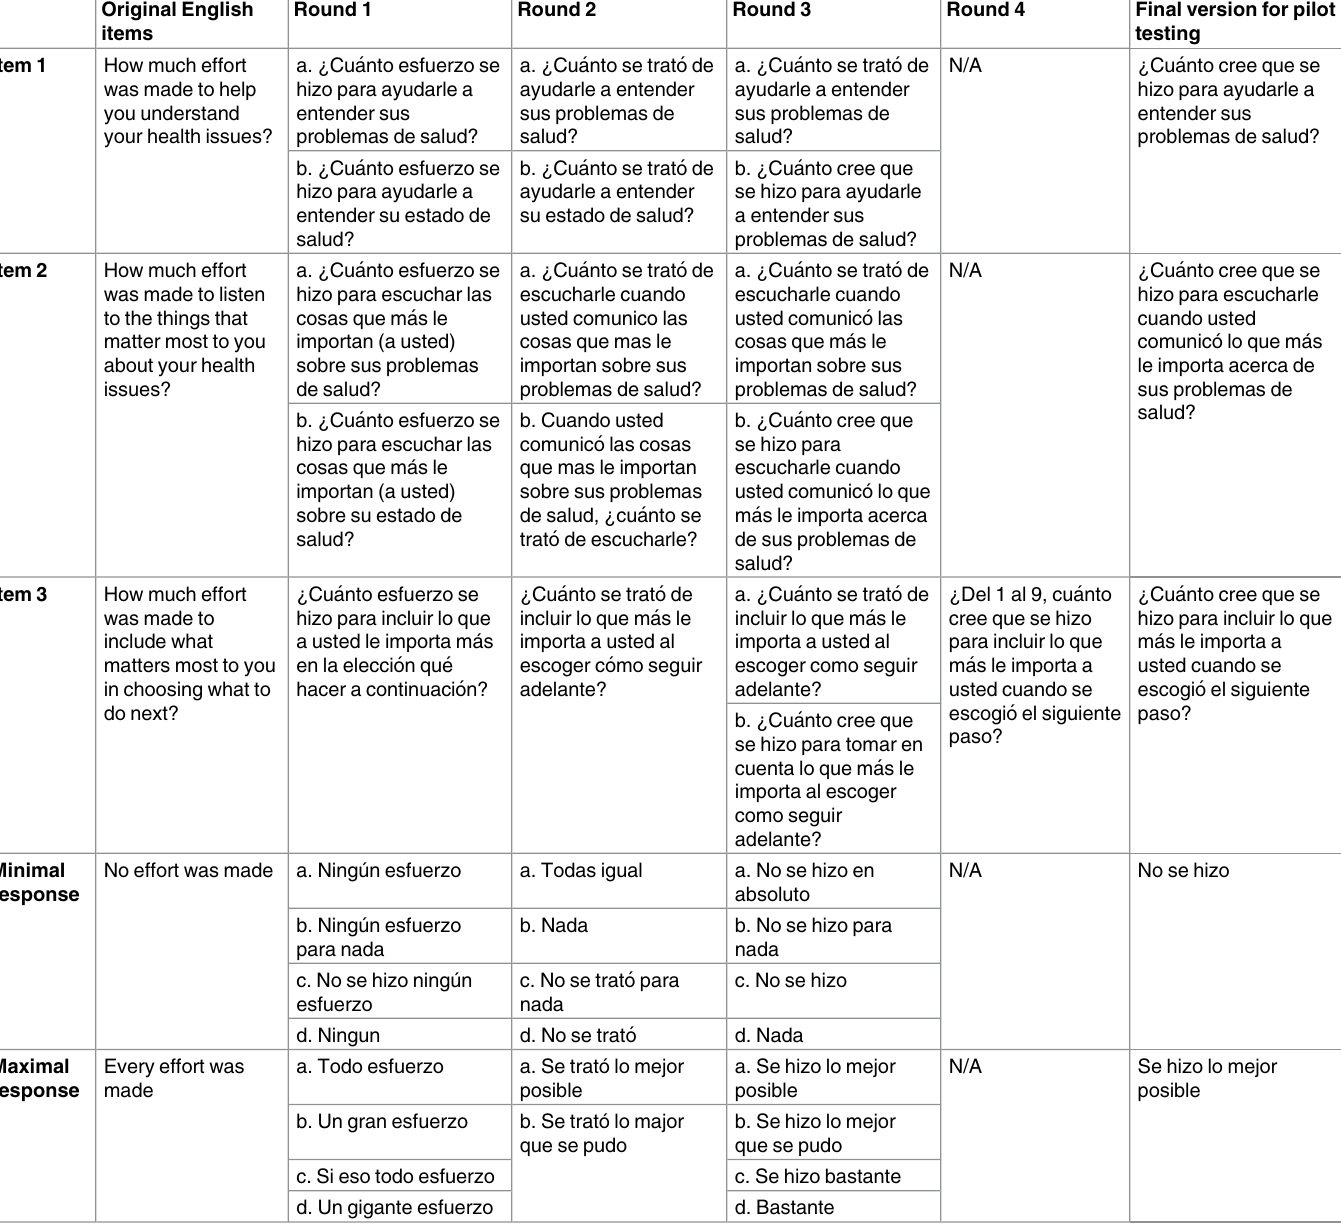
Table 3. Item progression: Cognitive